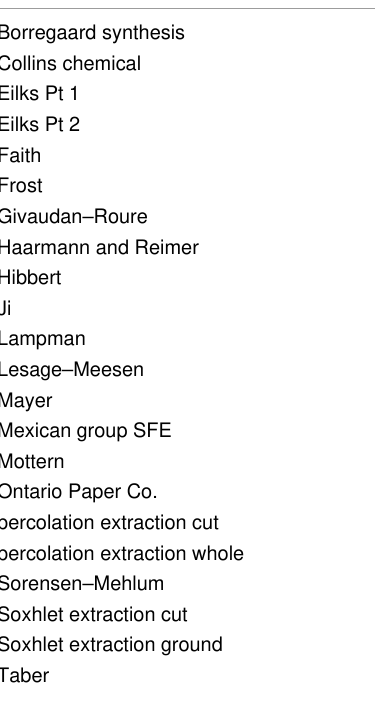
Alphabetized list of vanillin synthesis